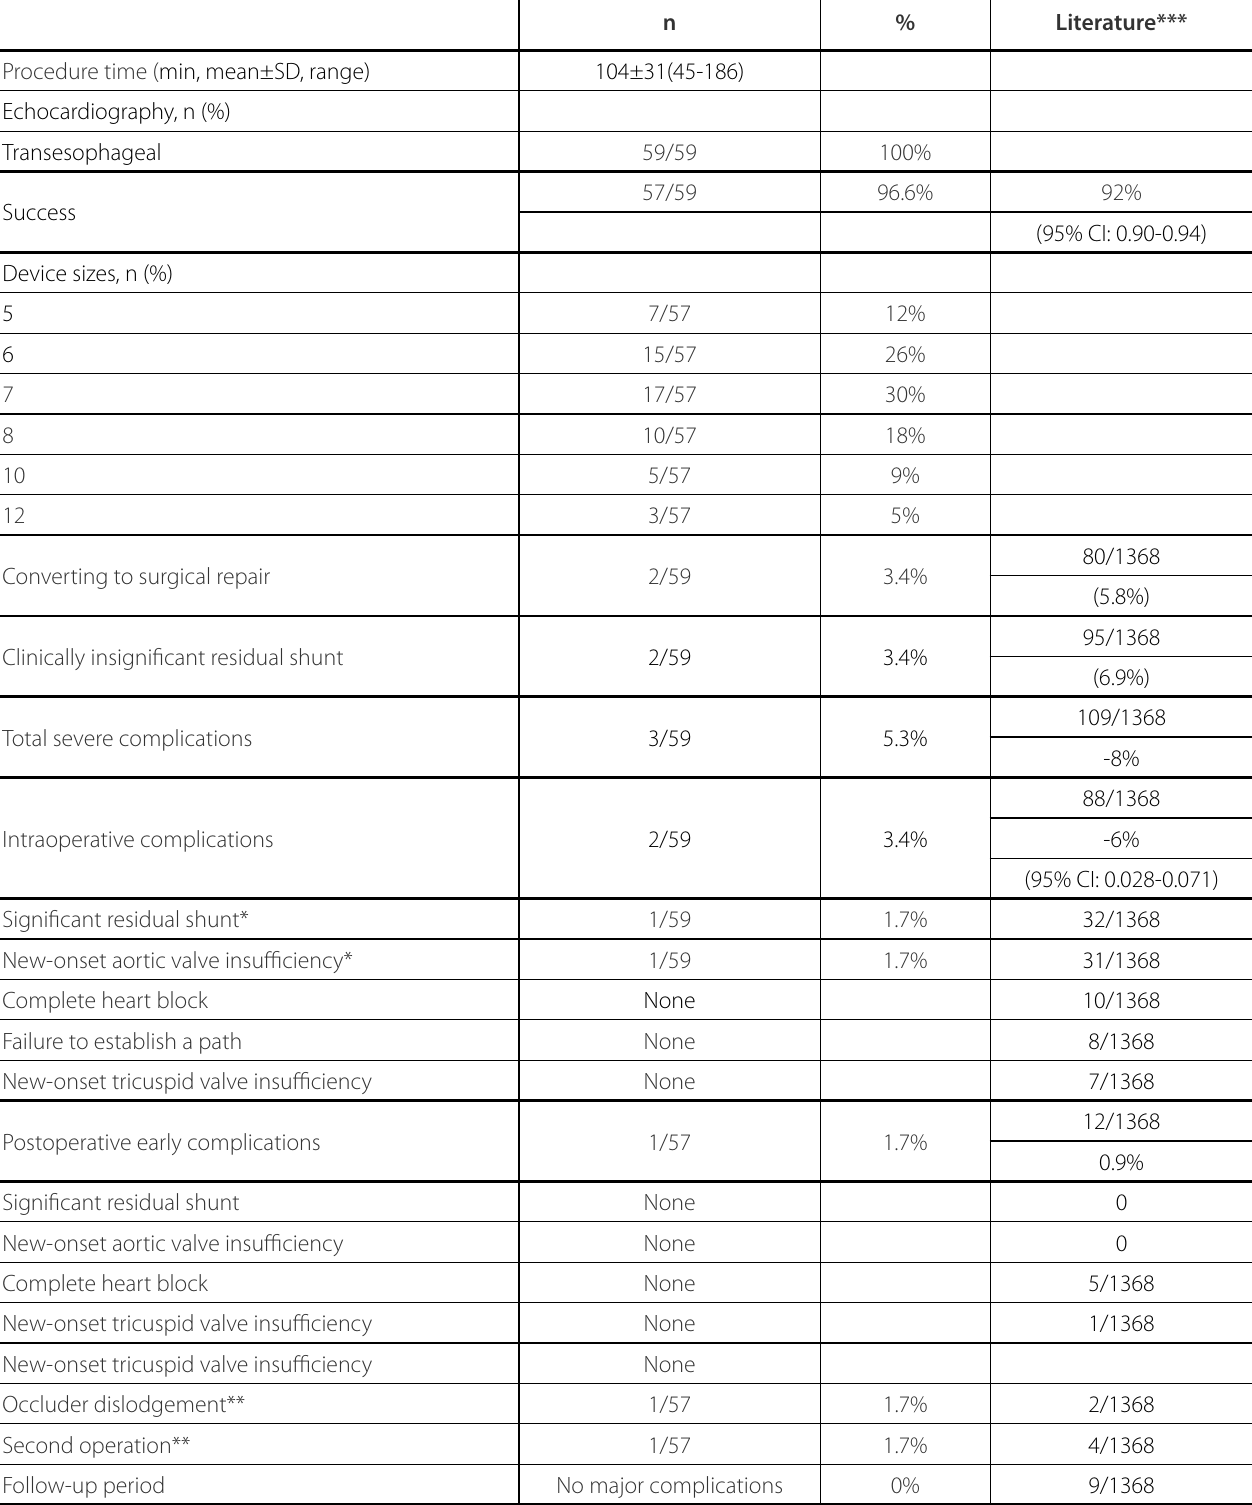
Table 2 . Procedure-related data.